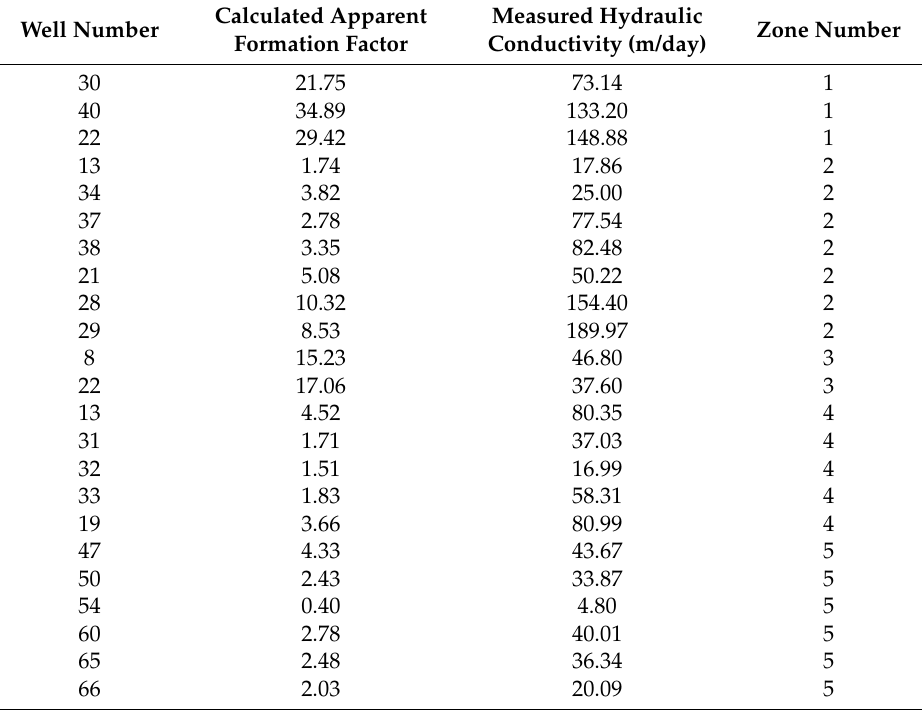
Table 2. List of the selected data pairs for the mapping of hydraulic conductivity and formation factor. Well Number